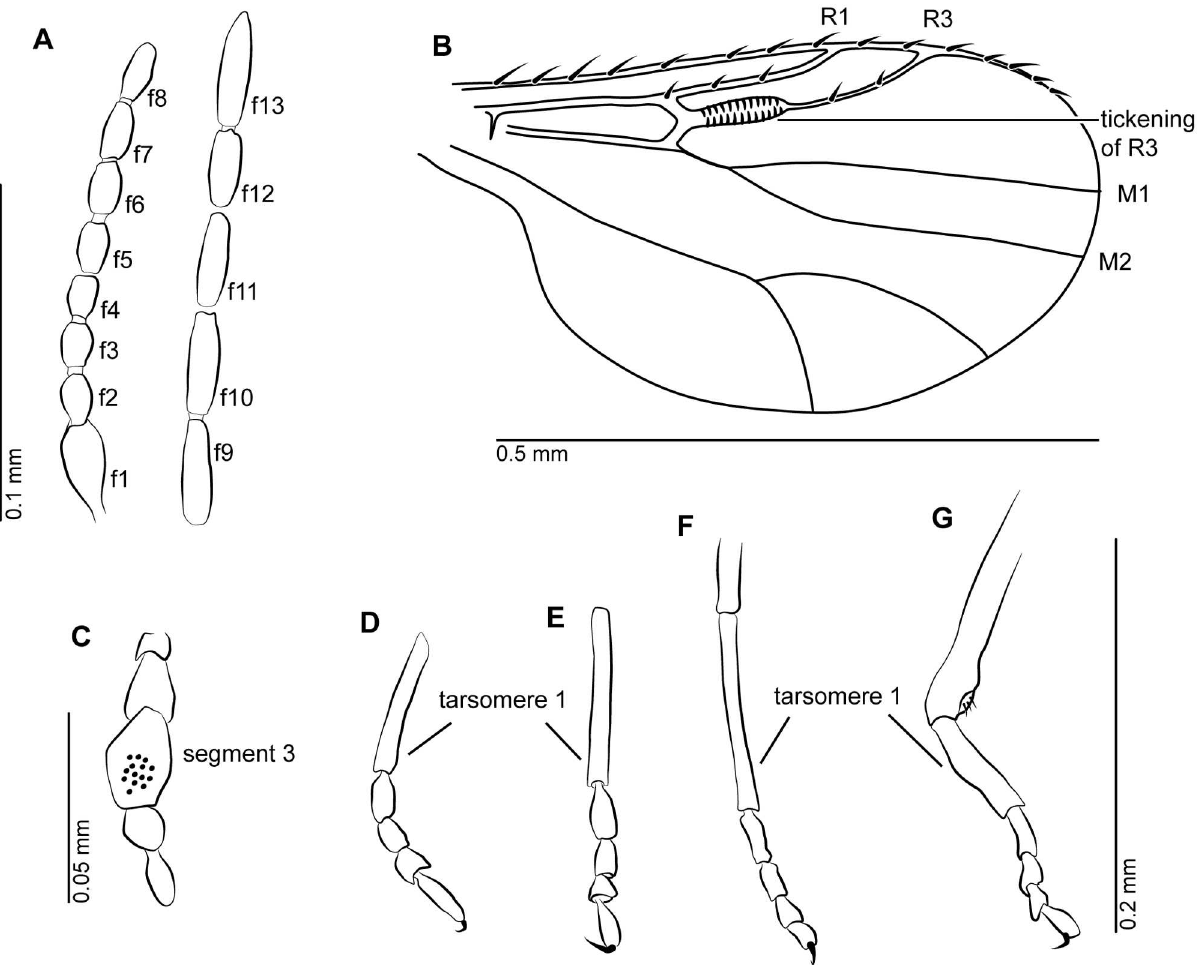
Fig 3. Female of Gedanohelea gerdesorum n. sp. from early Eocene Cambay amber. A . Flagellomeres 1–13 (f1-f13), paratypeno. Tad-513. B . Wing, holotypeno. Tad-857 C . Palpus, paratype no. Tad-513. D . Tarsus of fore leg, paratypeno. Tad-513. E . Tarsus of mid leg, holotype no. Tad-857. F . Tarsus of mid leg, paratype no. Tad-513. G . Tibia and tarsus of hind leg, paratypeno.